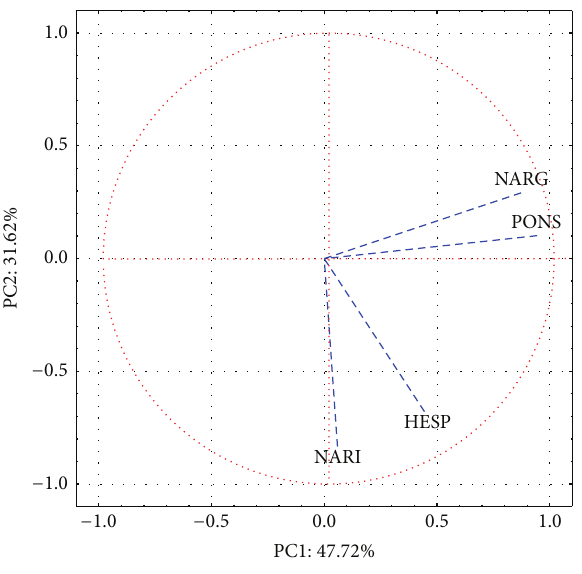
Figure 3: Score plot with PC1 × PC2.